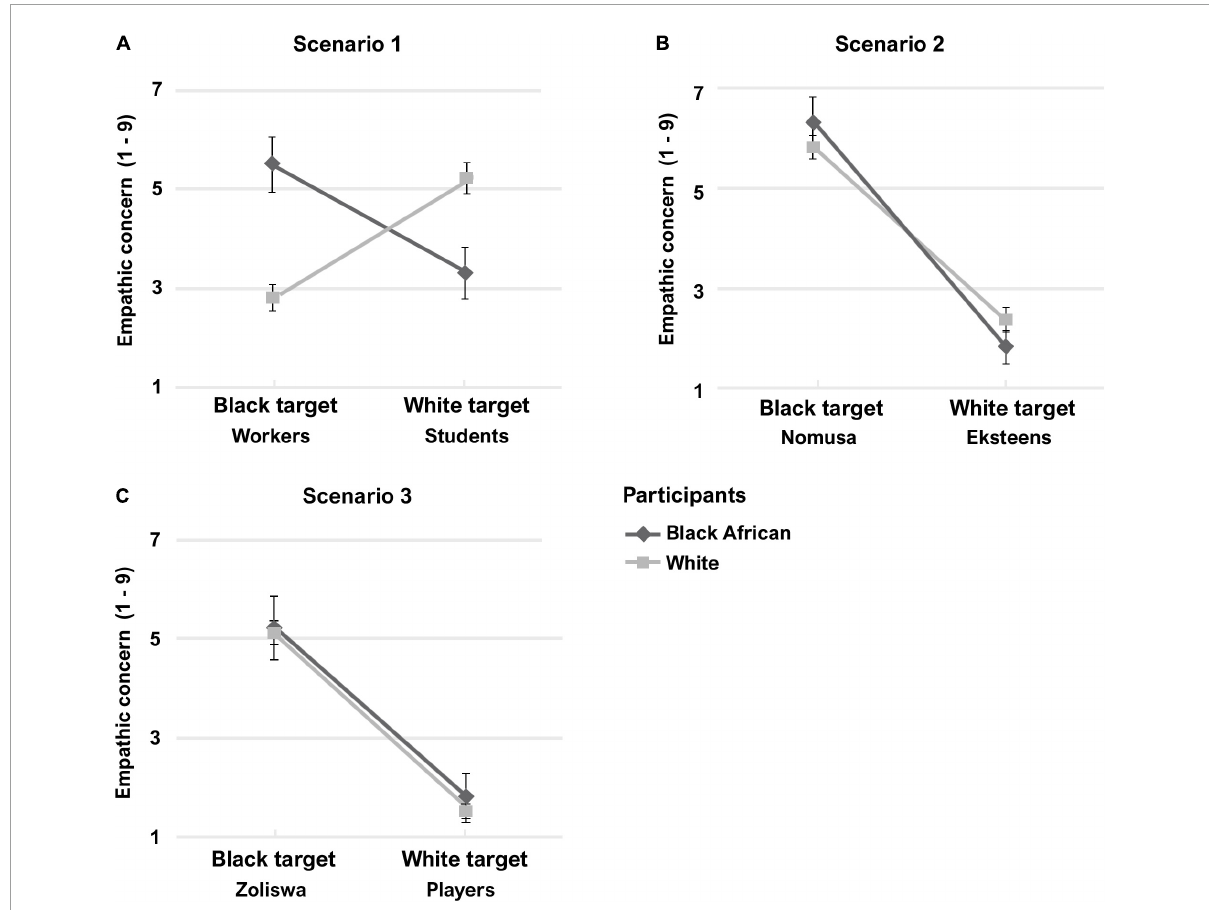
FIGURE2 Study 2 self-reported empathic concern ratings for (A) scenario 1 (structural racism), (B) scenario 2 (interpersonal injustice), and (C) scenario 3 (interpersonal racism). Error bars indicate standard error of the